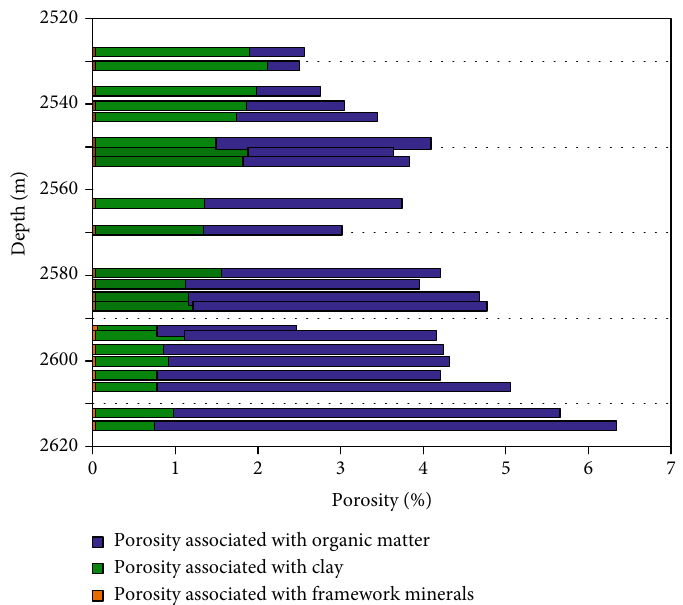
Figure 13: The semiquantitative estimation of porosity related to mineralogy using the linear combination approach.